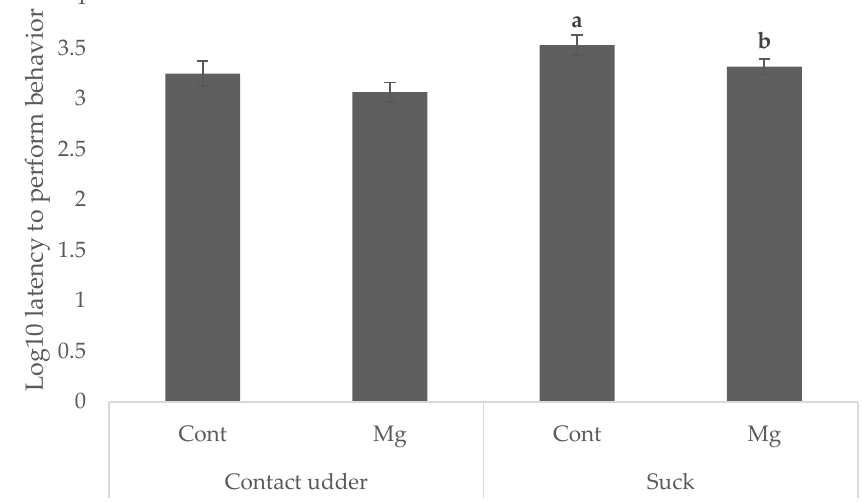
Figure 1. Mean ± s.e.m log 10 latency (in minutes) to contact the sow’s udder and successfully suck for piglets born to sows fed a standard lactation diet (Cont) and those supplemented with 21 g/day MgSO 4 (Mg) prior to farrowing. a,b Means within behavioral milestone not having the same superscript are significantly different ( p < 0.05).